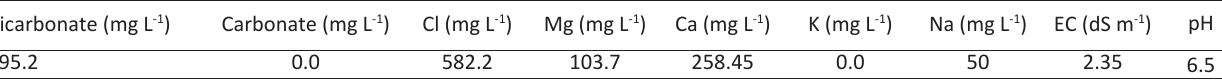
Table 2 - Irrigation water chemical properties at the experiment